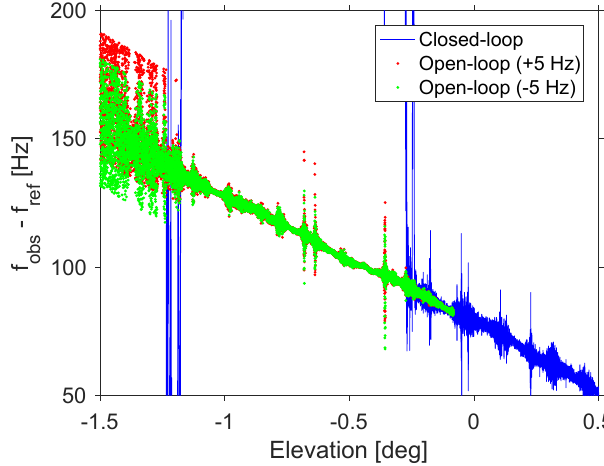
Figure 5. Open-loop performance in terms of the gain or loss in el- evation angle range compared to closed-loop tracking. The end ele- vations (cid:15) O / L and (cid:15) C/L are defined as the lowest angle with C /N 0 off off still exceeding 30dBHz. In general, O/L tracking lowers the final elevation angle by about 0 . 11 ◦ on average. However, in about 14% of the measurements C/L tracking outperforms the O/L channels, in a few cases by up to 1 ◦ . Red markers refer to O/L channel A and green to channel B.